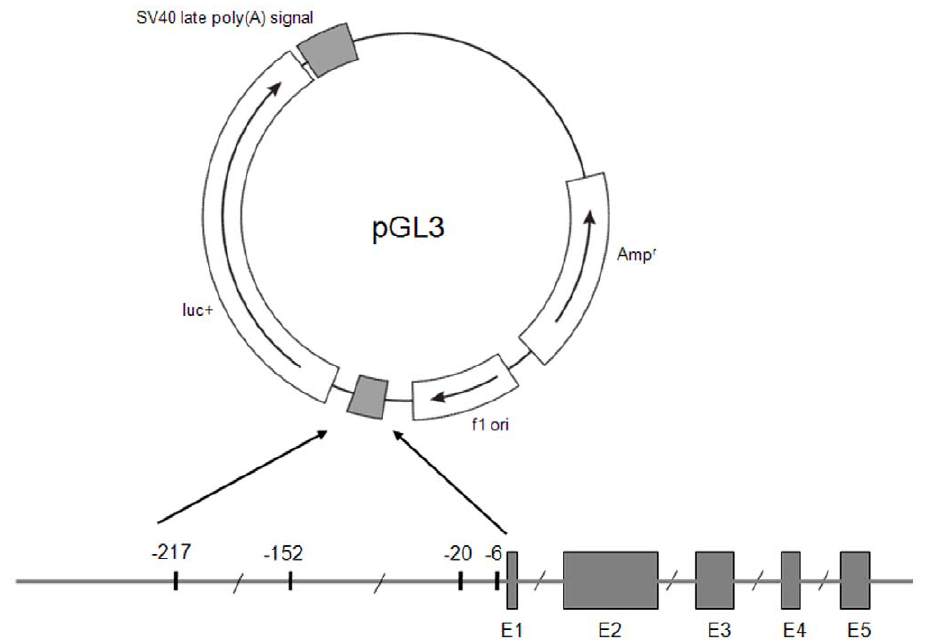
Figure 1. Construction of expression variants in pGL3 vector using oligonucleotides for the proximal AGT promoter. The oligonucleotides containing the proximal promoter region of the AGT gene from position 2 290 to + 35 were ligated in the pGL3 vector to produce the reporter construct. luc + = cDNA encoding the modified firefly luciferase; Amp r = gene conferring ampicillin resistance; f1 ori = origin of replication derived from filamentous phage; E = exon. according to AGT genotype. Six patients with chronic atrial fibrillation or without ability to maintain sinus rhythm during ECG recording were excluded.